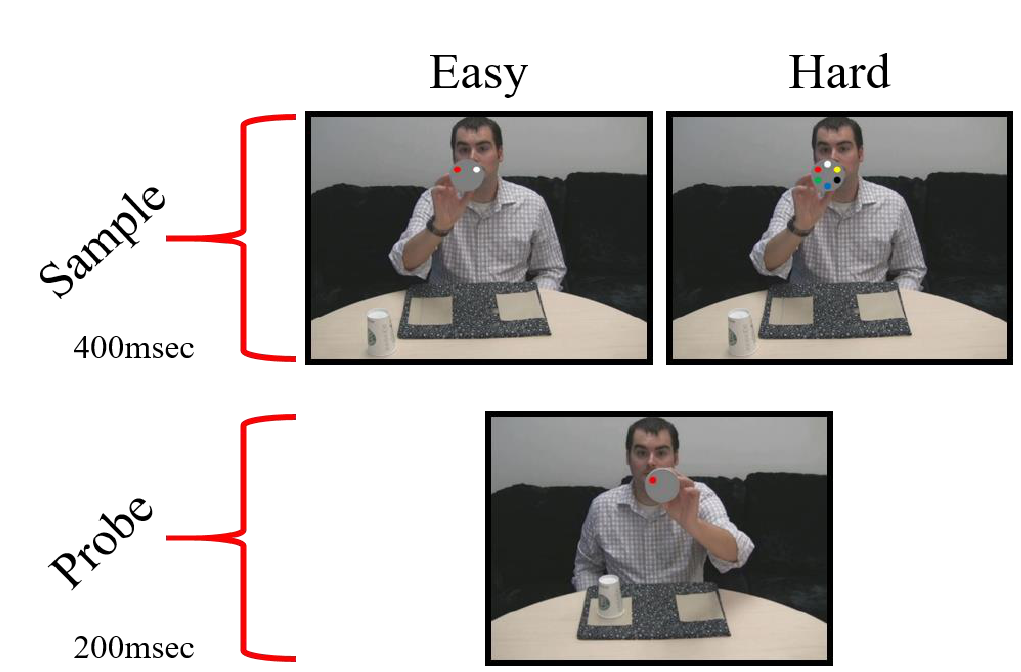
Figure 1 . Examples of MTS stimuli in the Easy and Hard conditions. The probe should elicit a “match”